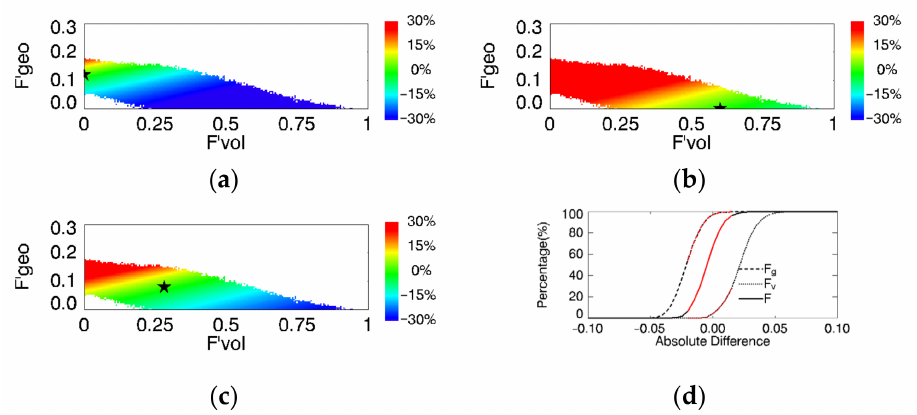
Figure 8. The Rd between the MODIS shortwave albedo and the albedo retrieved from the nadir reflectance using F g ( a ), F v ( b ), and F ( c ). The colors refer to the value of relative difference. ( d ) The distribution of accumulative Ad. The pentacle represents the location of F used in the albedo retrieval. The dashed, dotted, and solid lines in ( d ) refer to F g , F v , and F . The red lines refer to the Ad between − 0.02 and